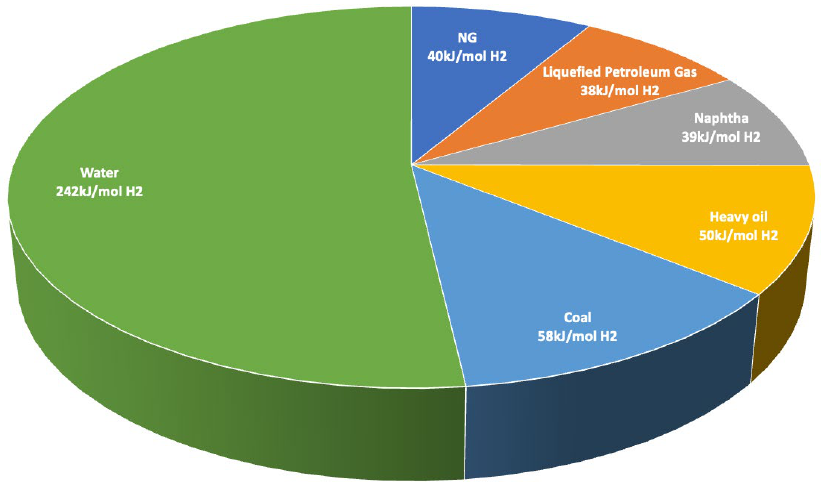
Figure 4. C omparison among different sources in terms of energy demand.